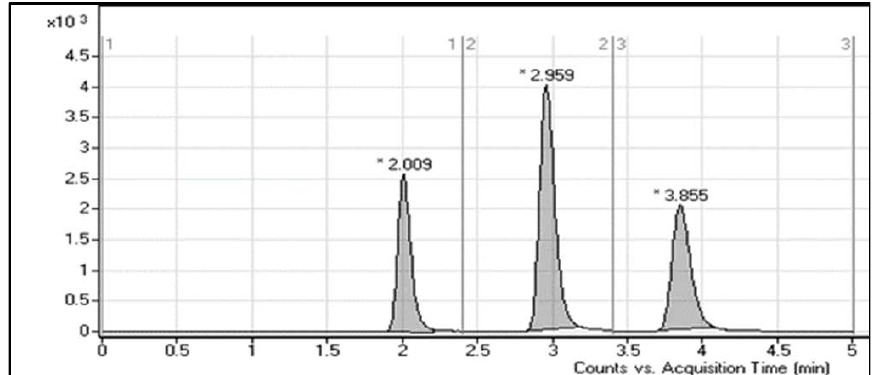
Figure 5. Typical multiple reaction monitoring (MRM) chromatograms for in vivo rat plasma sample 2.0 h after oral (gavage) administration of 10 mg/kg LE300; LE300 (2.01 min), KLE300 (2.96 min) and IS (3.86 min).